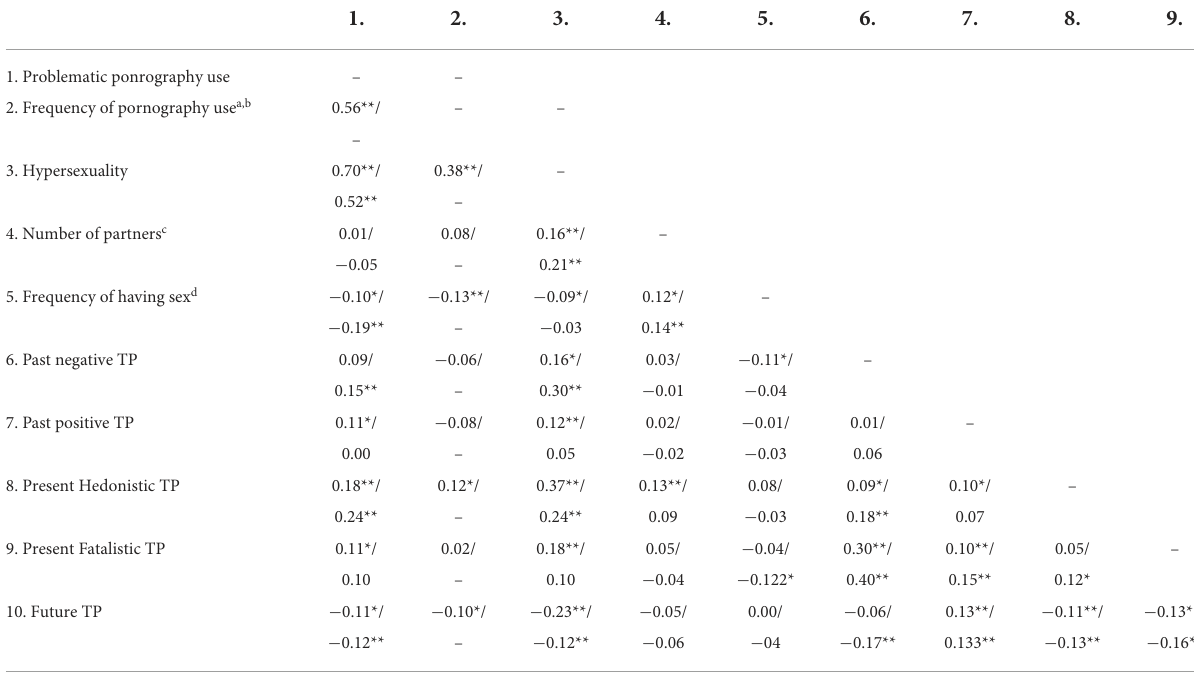
TABLE 2 Correlations between time perspectives, problematic pornography use, frequency of pornography use, hypersexuality, number of sexual partners, and frequency of having sexin Sample 1 and Sample